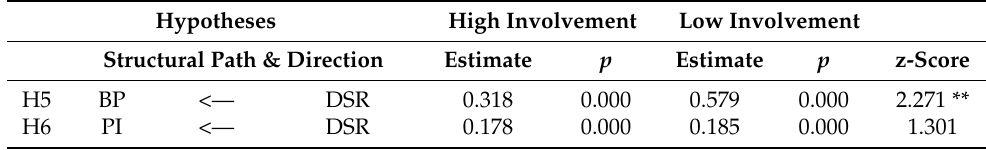
Table 6. Path wise moderation effect-group